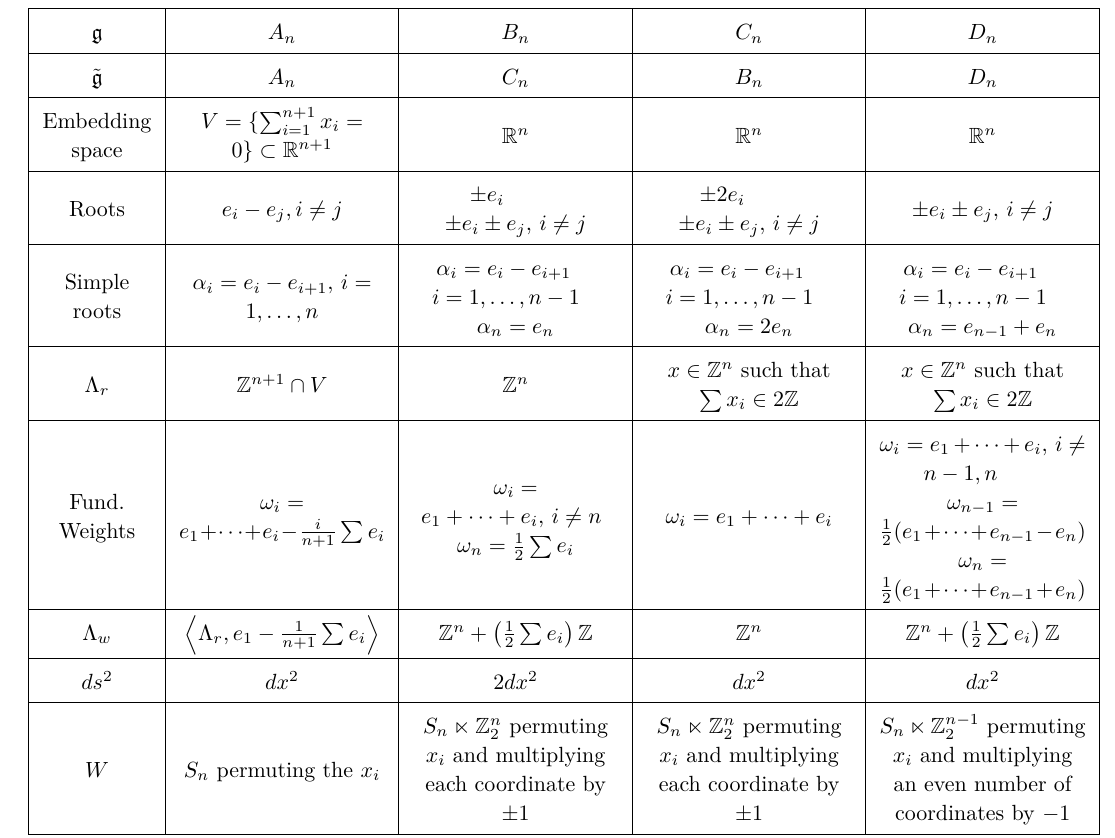
Table 6 . Description and properties of the A, B, C, and D type root